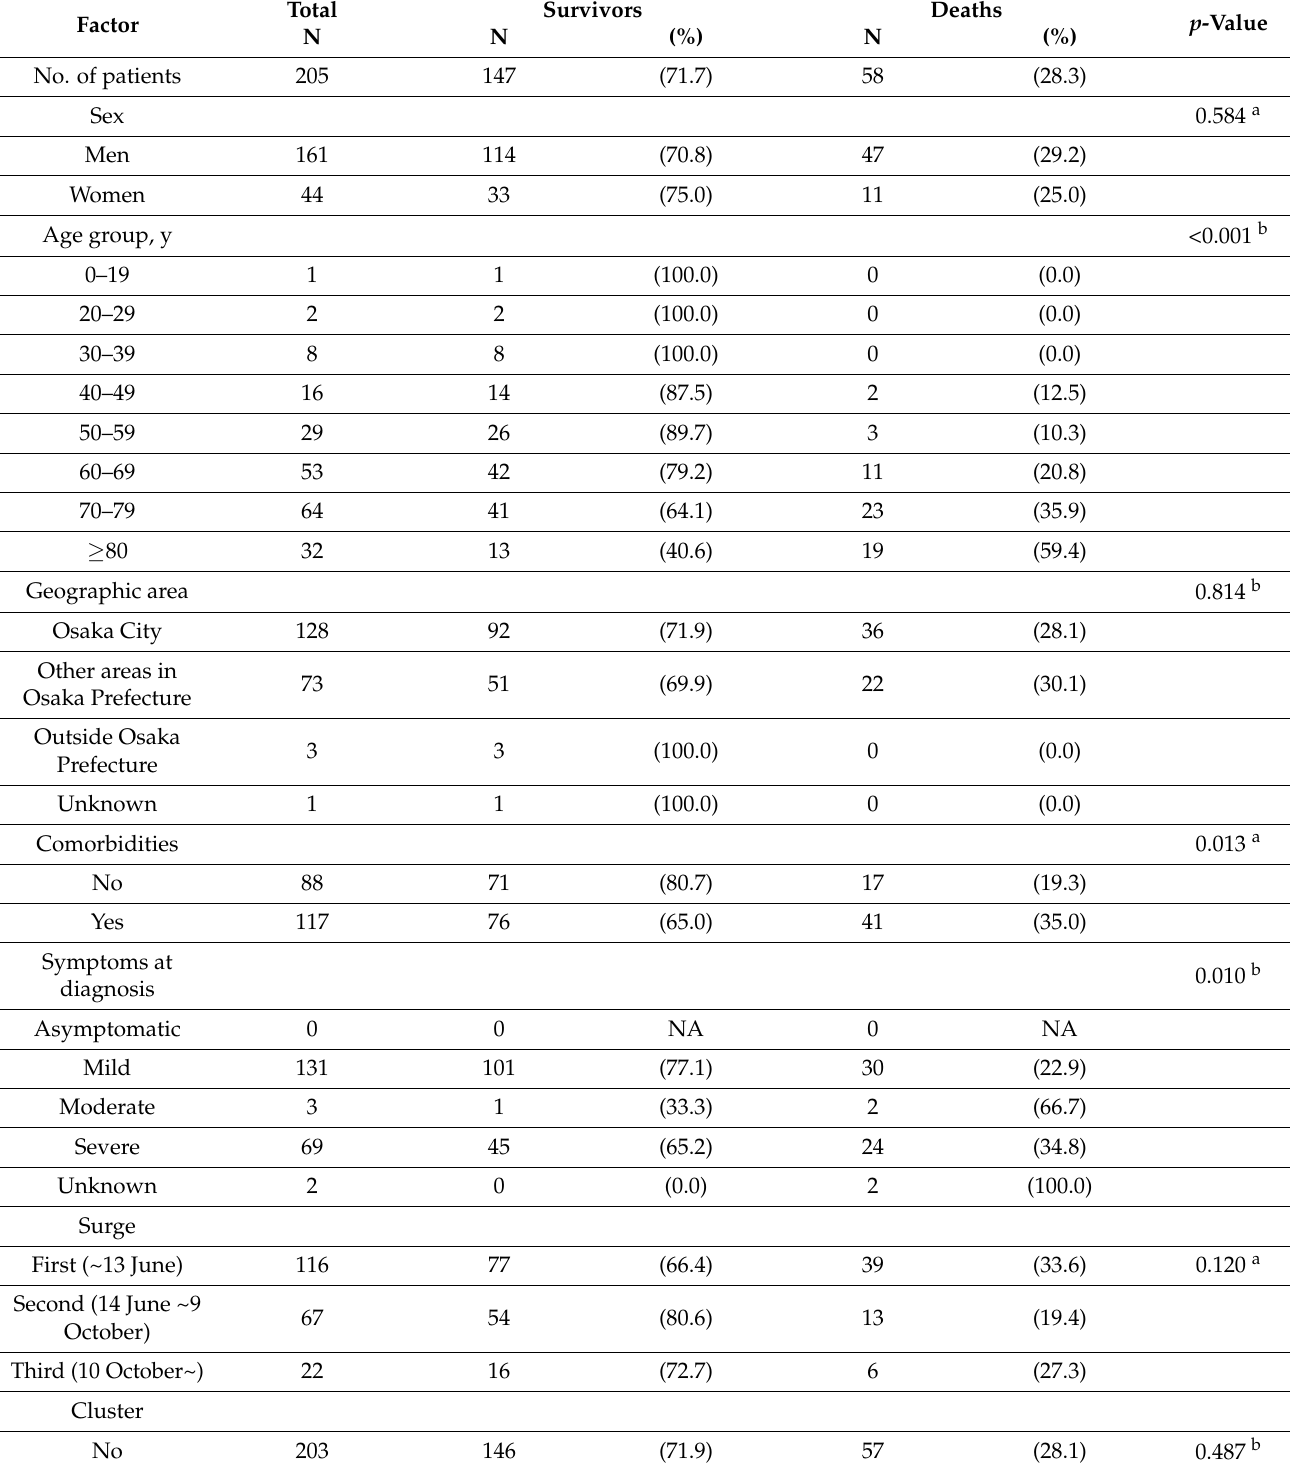
Table 1. Epidemiological characteristics of patients admitted to the intensive care unit in Osaka,